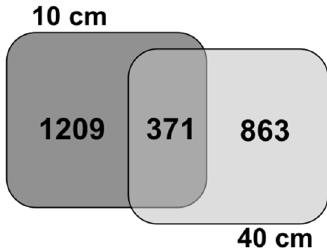
Figure 4. Venn diagram of sequences from mangrove samples at 10 and 40 cm depths. Sequences were grouped into OTUs based on distance sequence similarity of 97% separated by